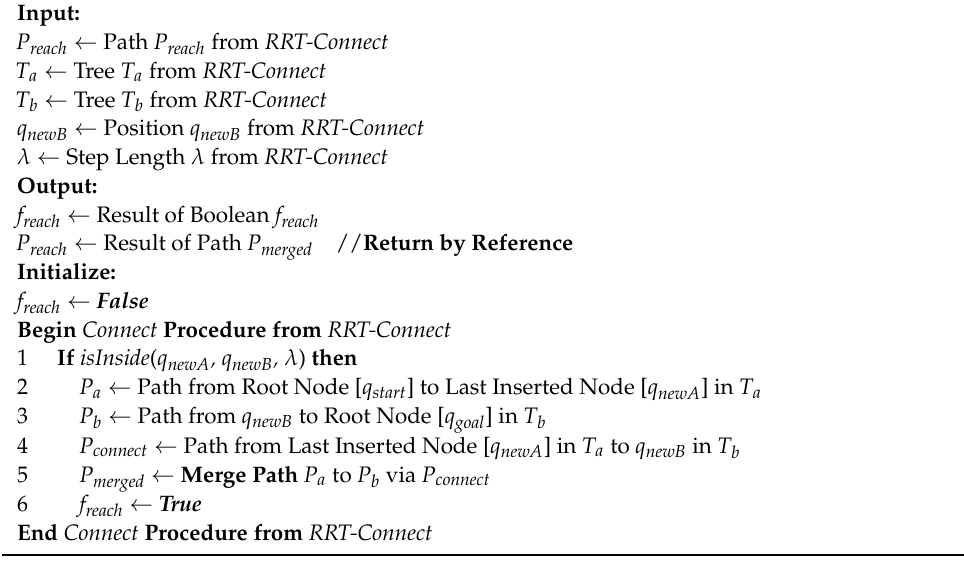
Figure 3. The ‘Extend’ method from RRT-Connect algorithm. Algorithm 3 Pseudocode of the Original ‘Connect’ Method from the RRT-Connect Algorithm